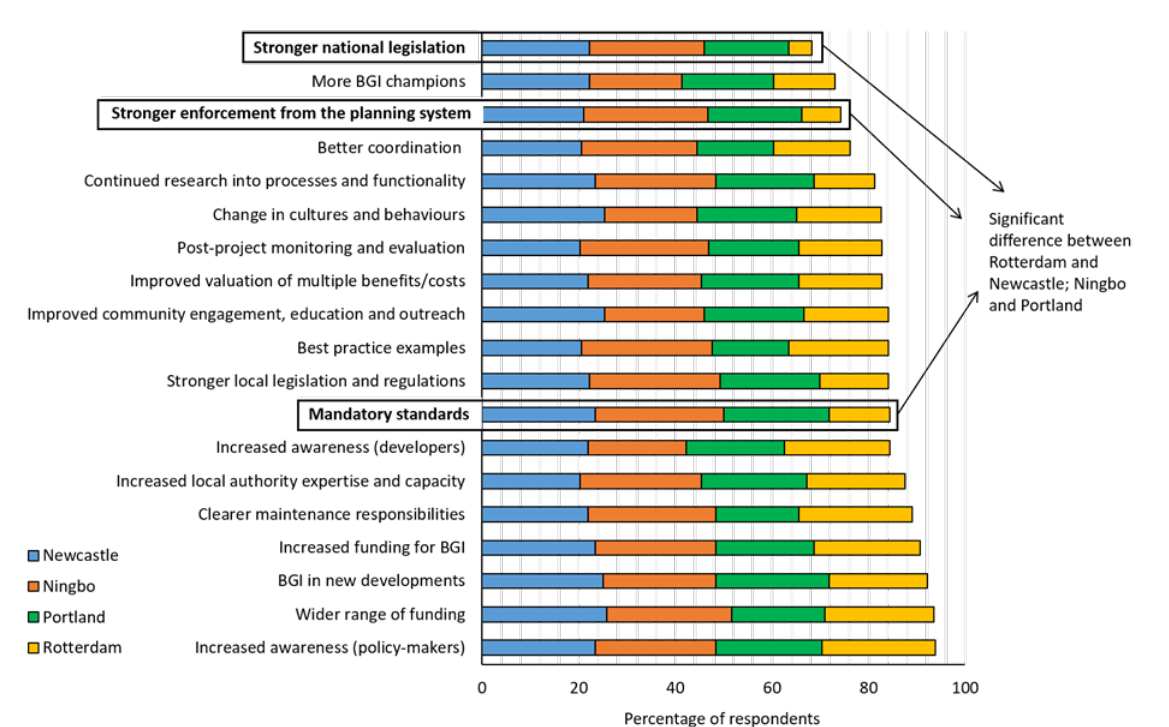
Figure 7. The percentage of respondents in each city that regarded the changes needed to improve the uptake of Blue-Green Infrastructure (BGI) as very important or important. The coloured stacked bars represent the four cities as per the legend; added together this gives the percentage of the whole sample population that regarded the strategies as very important or important (the remaining percentages refer to those who scored each option as either ‘neither significant or insignificant’, ‘insignificant’, ‘very insignificant’ or ‘do not know’).